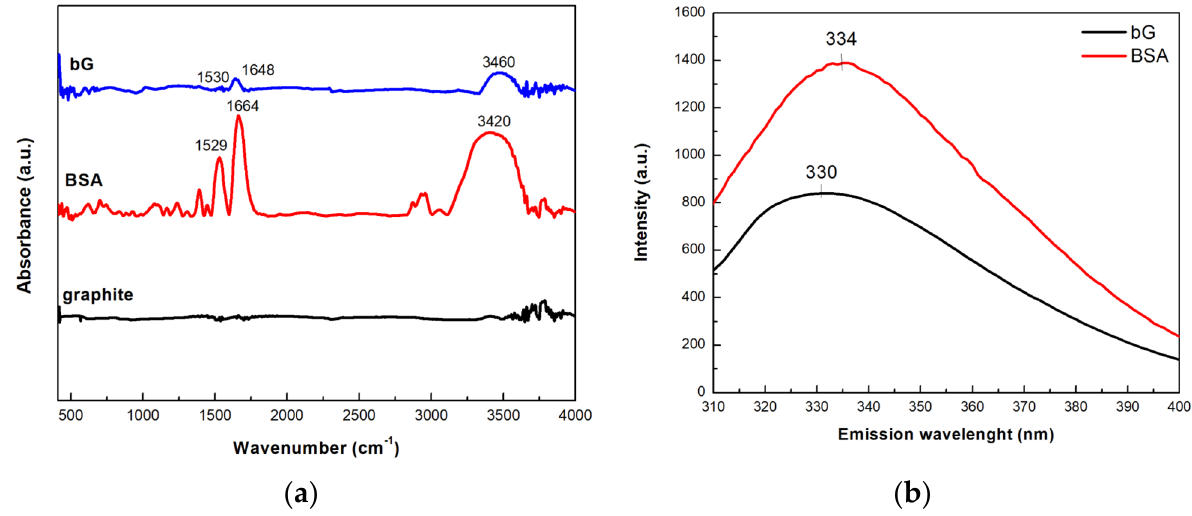
Figure 7. ( a ) FTIR and ( b ) fluorescence spectra of graphite, BSA, and